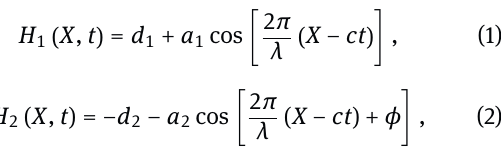
in which a 1 , b 1 are the amplitudes of the waves, d 1 + d 2 is the width of the channel, λ is the wave length, ϕ is the phase difference which varies in the range 0 ≤ ϕ ≤ π .